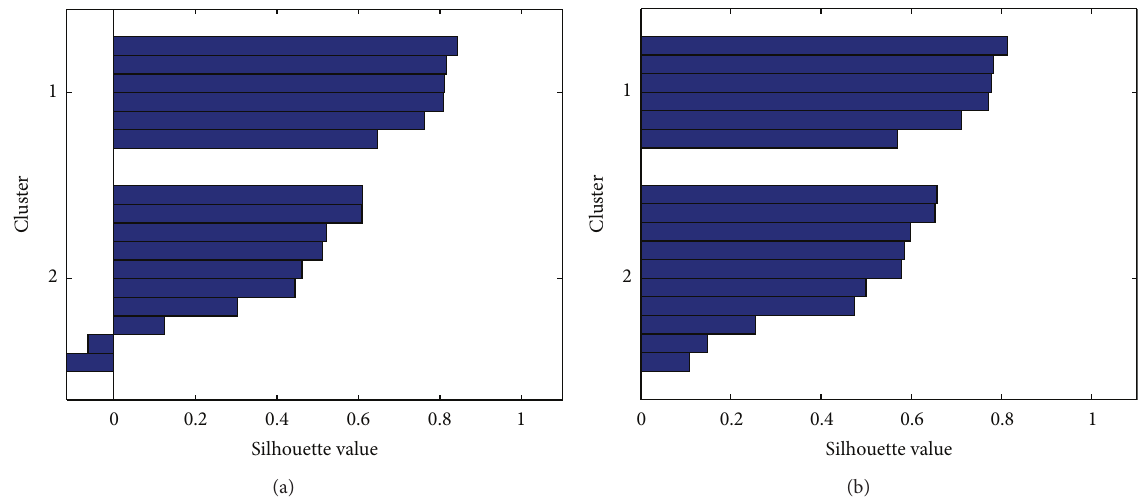
Figure 3: (a) Silhouette plot for Euclidean RBF kernel: negative Silhouette indicates misclassification. (b) Silhouette plot for proposed RBF kernel: large Silhouette widths with no negatives.